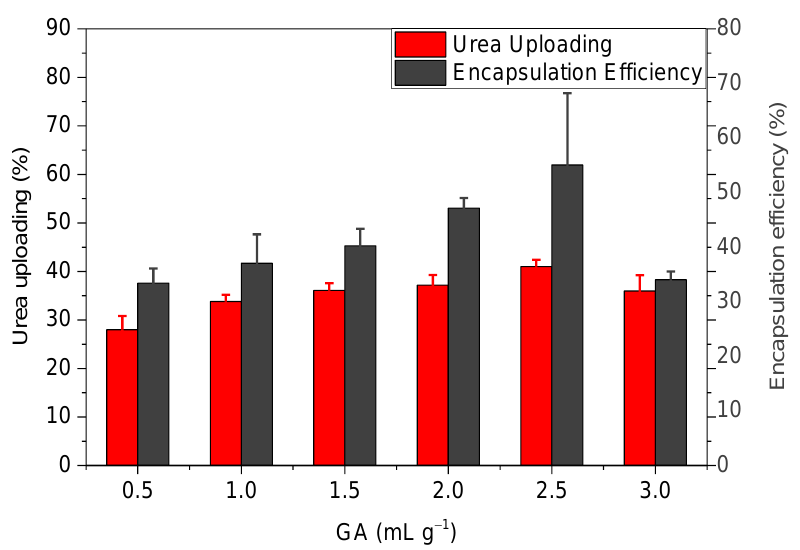
Figure 4. Effect of the GA content on the UG 2:1 films’ urea uploading (%) and encapsulation efficiency (%). (Bars represents stand deviation). All values in the figure are represented as mean ± standard deviation.